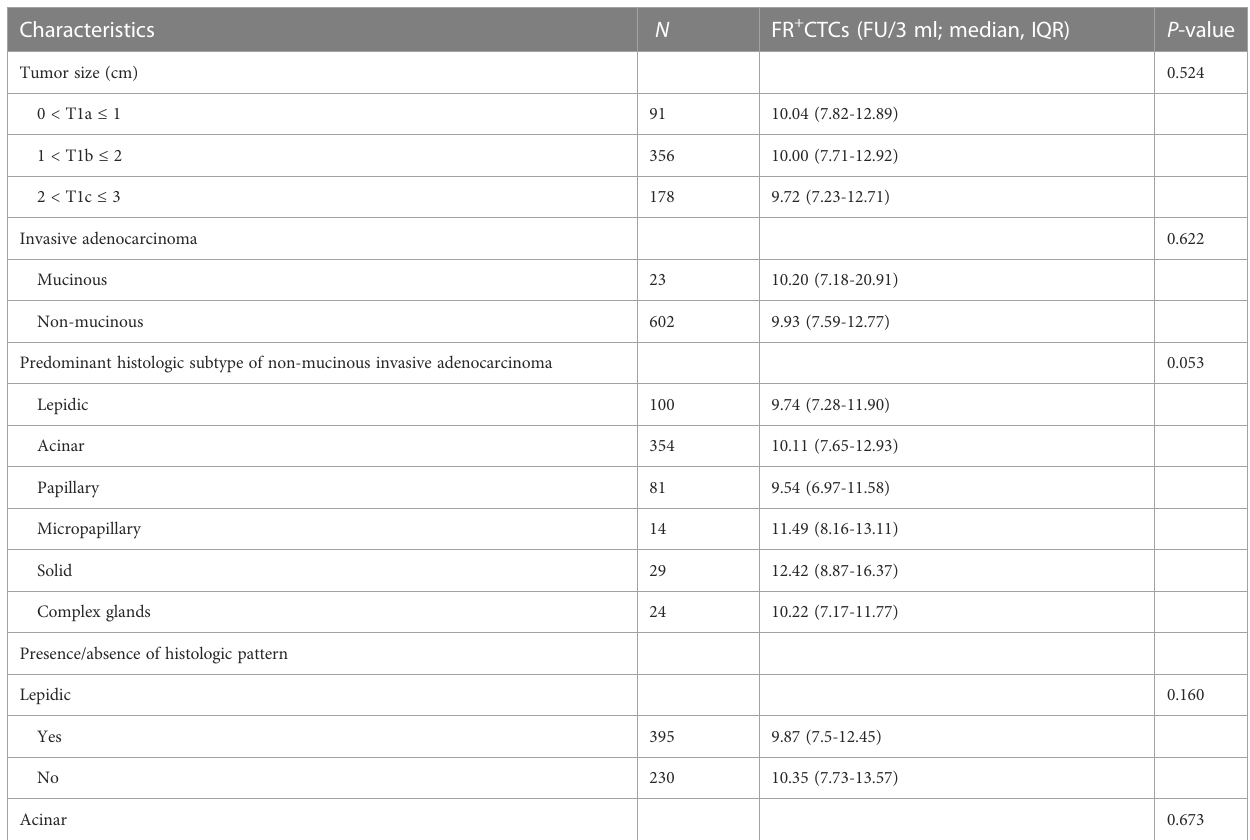
TABLE 1 Baseline characteristics of 625 patients with invasive adenocarcinoma. Characteristics N FR + CTCs (FU/3 ml; median, IQR) P